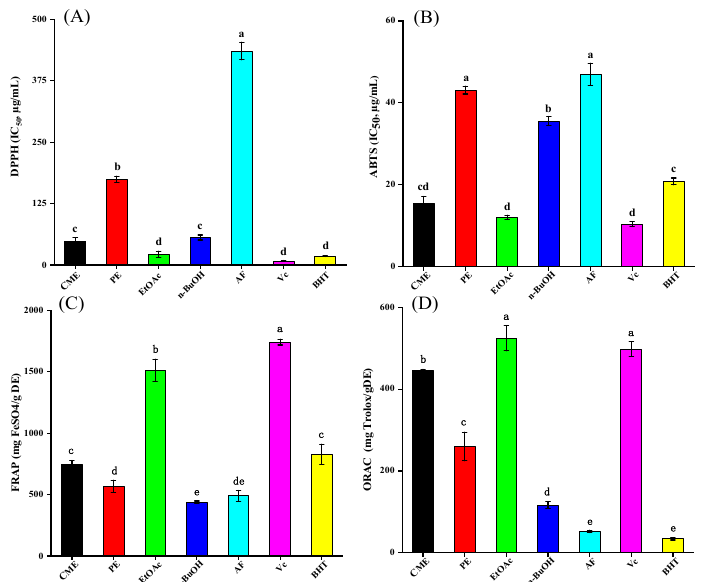
Figure 1. The antioxidant activity of samples or controls. ( A ) DPPH· scavenging activity (DPPH). ( B ) ABTS· + scavenging ability (ABTS). ( C ) Ferric reducing antioxidant power (FRAP). ( D ) Oxygen radical absorbance capacity (ORAC). CME = crude methanol extract; PE = petroleum ether fraction; EtOAc = ethyl acetate fraction; n-BuOH= n-Butanol fraction; and AF = aqueous fraction. The columns with different lowercase letters represent a significant difference at p < 0.05.